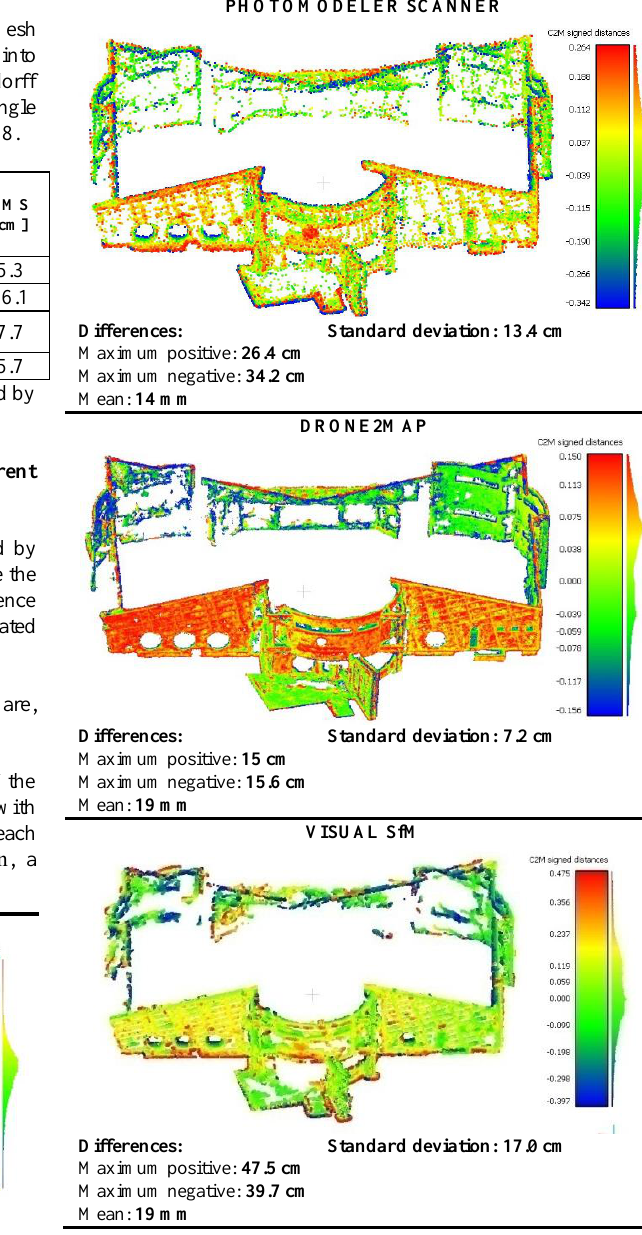
Figure 11. The residuals of the facades UAS point clouds obtained by using different